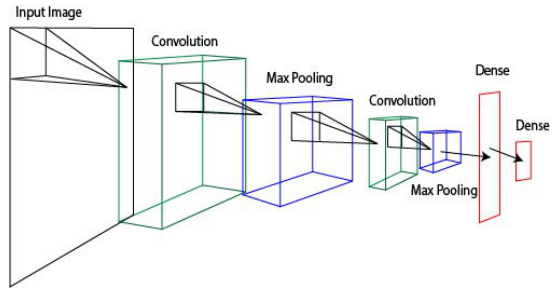
Figure 6. Architecture of the convolutional neural network used for perceiving the individual beads in clusters.